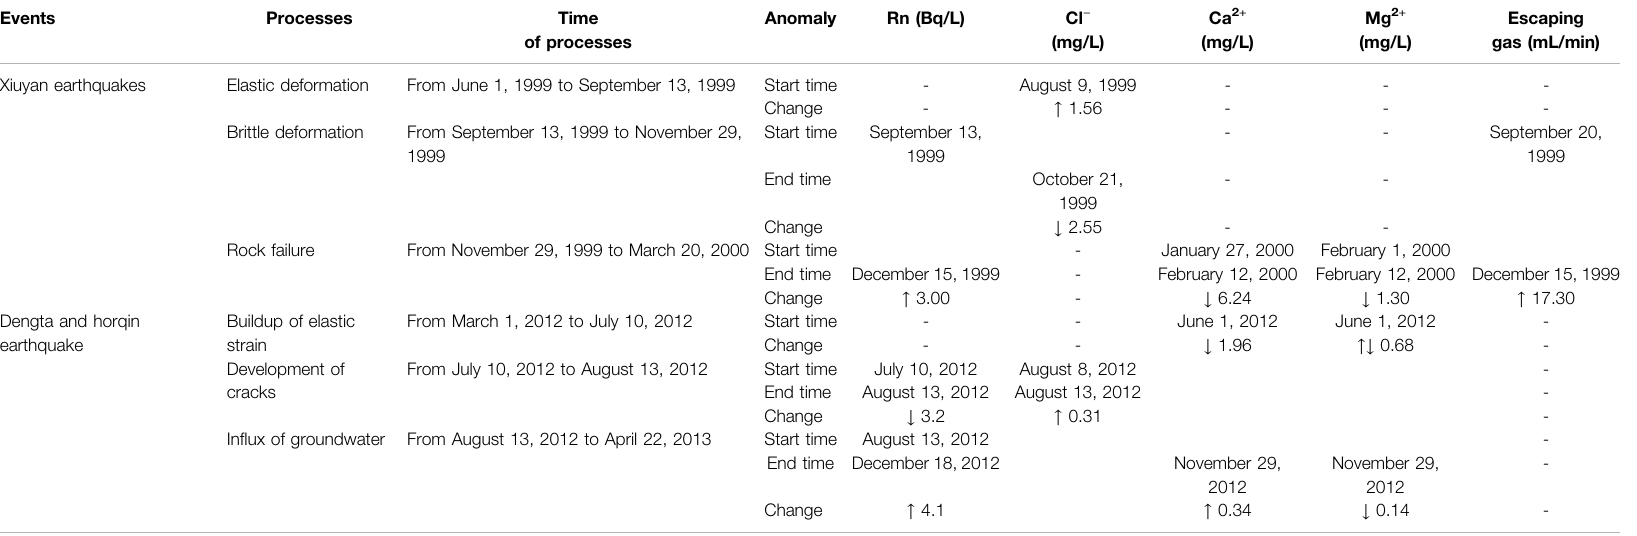
“ - ” represents the normal value; The blank space represents keeping in an abnormal